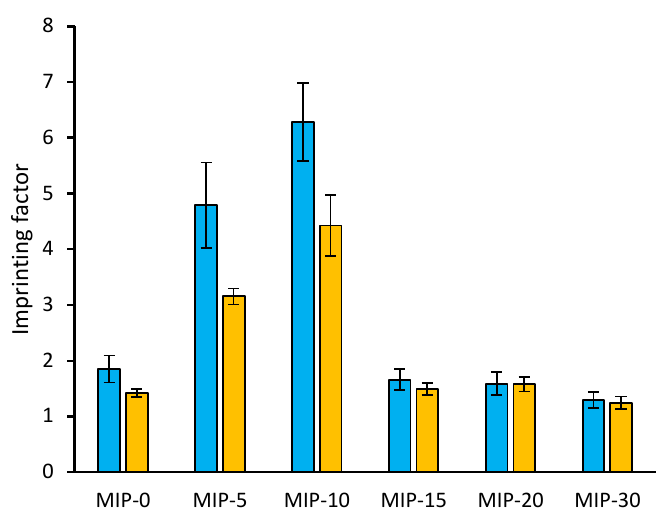
Figure 3. Imprinting factors ( ± standard error) for diclofenac (cyan bars) and mefenamic acid (yellow bars), calculated as the ratio between the equilibrium binding constants relative to the ligand for the imprinted and non-imprinted polymers.